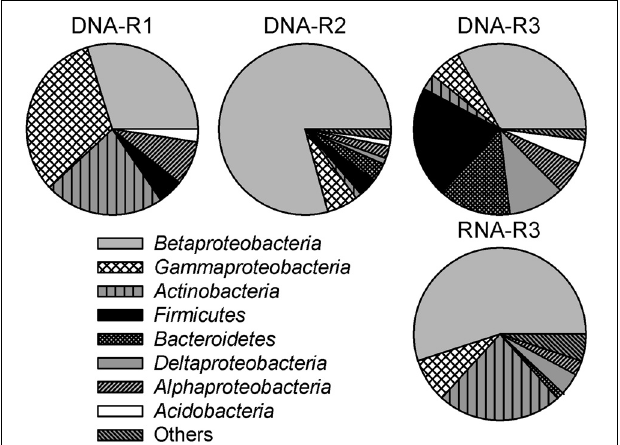
FIGURE 3 | Bacterial community composition in 16S rRNA (gene) clone libraries derived from creek sediment of sites R1 (DNA-R1), R2 (DNA-R2), and R3 (DNA-R3 and RNA-R3) in the former Ronneburg uranium-mining district, Germany. Calculations were based on the total number of clones associated with phylotypes of sequenced representatives at the phylum level, or class level for Proteobacteria . The category “others” includes the low abundance groups Chloroflexi , Epsilonproteobacteria , Gemmatimonadetes , Cyanobacteria , Nitrospirae , Planctomycetes , Synergistetes , and the candidate phylum